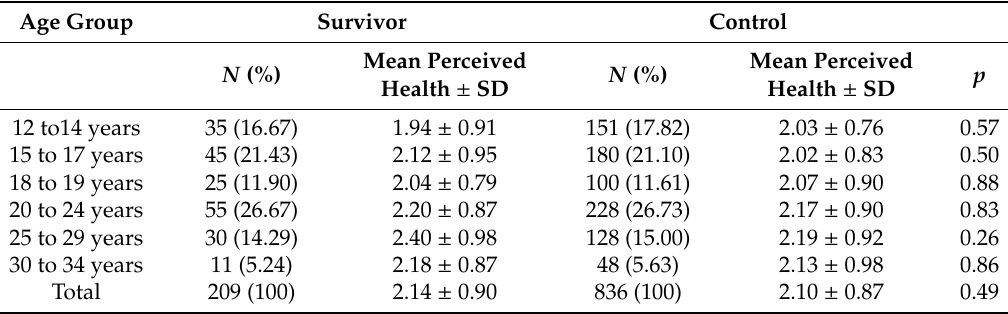
Table 3. Perceived health of controls and survivors of childhood cancer by age groups. Age Group